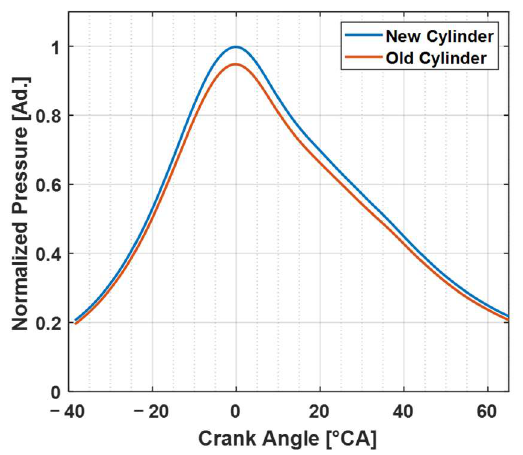
Figure 8. Trend of BSFC ( a ) and pressure peak ( b ) as a function of MFB50 for the working point 1800 rpm and 22 bar BMEP.